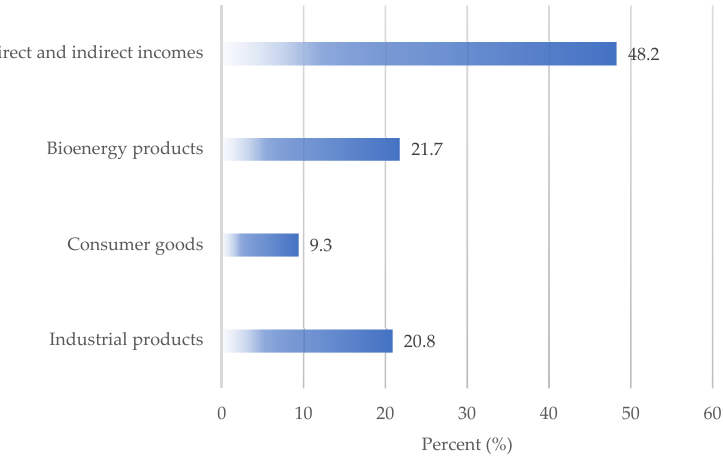
Figure 3. The dimensions of forest bioeconomy. Source: Authors’ own work (2022).